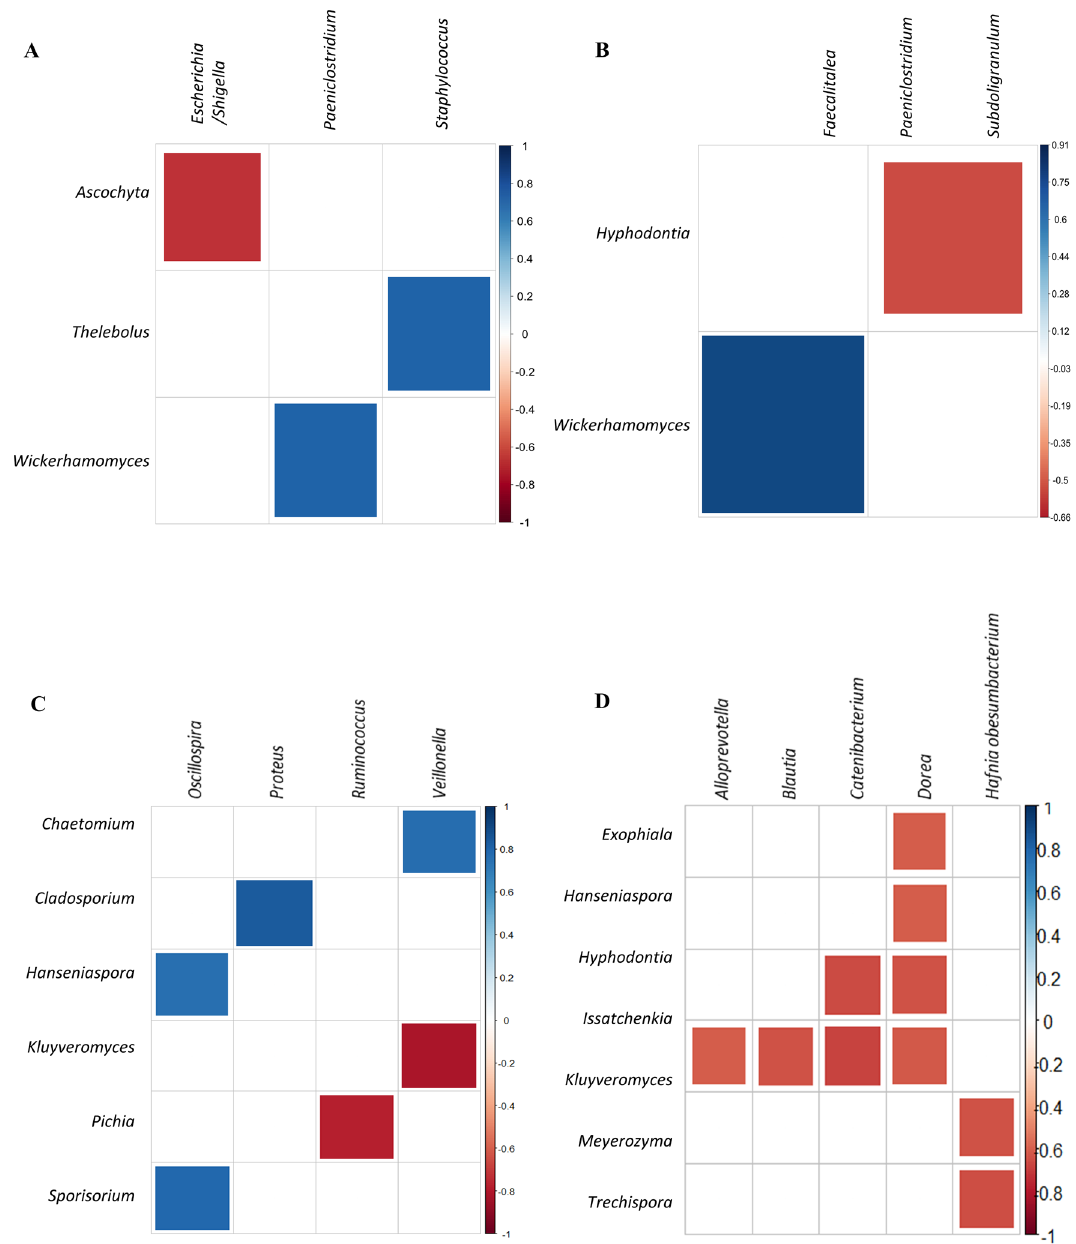
Figure 3. Possible interactions between kingdoms. Correlogram plots between bacteria and eukaryotes. ASVs corresponding to the most abundant phyla (Bacteroidetes, Firmicutes, Proteobacteria, Ascomycota and Basidiomycota) were compared. Outliers were deleted to only compare the ASVs corresponding to the most abundant genera (Spearman’s rho correlation method with Benjamini–Hochberg correction). Only were considered strong correlations (− 0.7 < ρ > 0.7; p value < 0.05). ( A ) CO/− group. ( B ) CO/+ group. ( C ) HCFO/− group. ( D ) HCFO/+ group. Figure created on R studio with psych package 64,72